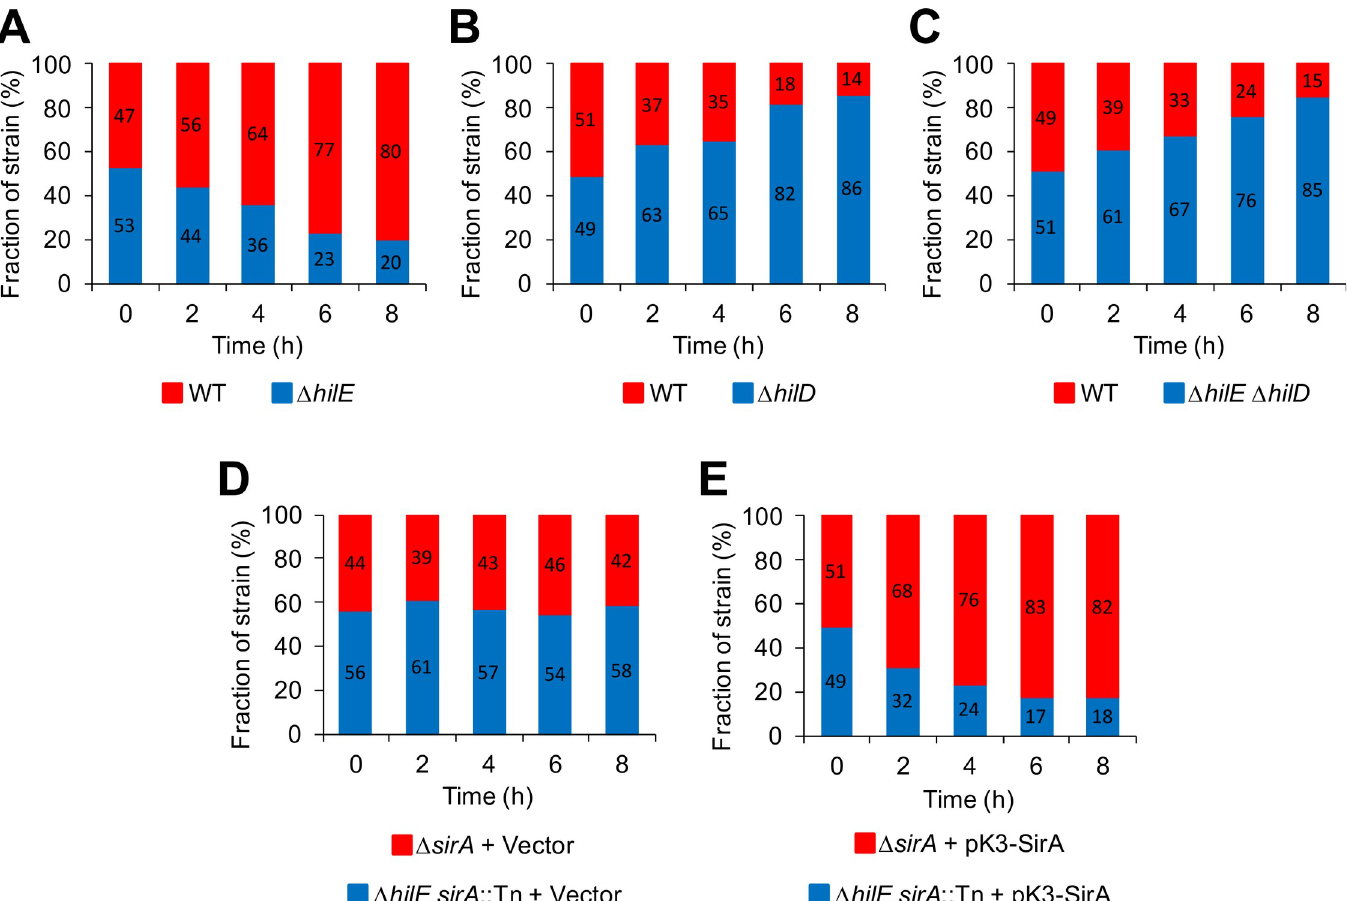
Fig 6. Detrimental effect on bacterial growth by the expression of genes controlled by HilD. In vitro competitive growth (A) between WT S . Typhimurium strain and isogenic Δ hilE mutant, (B) between WT S . Typhimurium strain and isogenic Δ hilD mutant, (C) between WT S . Typhimurium strain and isogenic Δ hilE Δ hilD mutant, (D) between the Δ sirA and Δ hilE sirA ::Tn 10 d mutants carrying the pMPM-K3 vector, and (E) between the Δ sirA and Δ hilE sirA ::Tn 10 d mutants carrying the pK3-SirA plasmid expressing SirA, was determined by counting CFUs for each strain from samples taken at 0, 2, 4, 6 and 8 h of bacterial mixed cultures grown in LB at 37˚C with shaking. CFUs are represented as fraction (percentage) of each strain in the respective mixed culture. Data represent the average of three independent experiments.